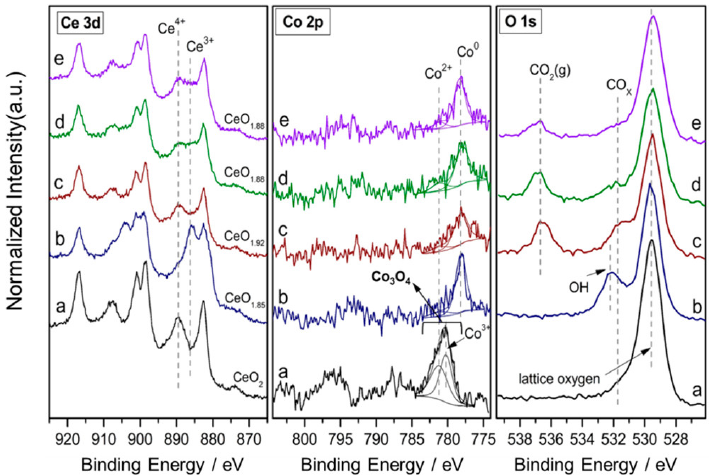
Figure 3. NAP-XPS spectra of the Ce 3d, Co 2p and O 1s regions of 10 wt % Co / CeO 2 catalyst ( a ) as prepared at 300 K, ( b ) cooled to 300 K after 1 h of H 2 pretreatment at 823 K and during the dry reforming of methane (DRM) reaction (~ 0.1 mbar of CH 4 + ~ 0.1 mbar of CO 2 ): ( c ) at 300 K, ( d ) 673 K and ( e ) 773 K. Reprinted with permission from [147], copyright 2018, American Chemical Society.